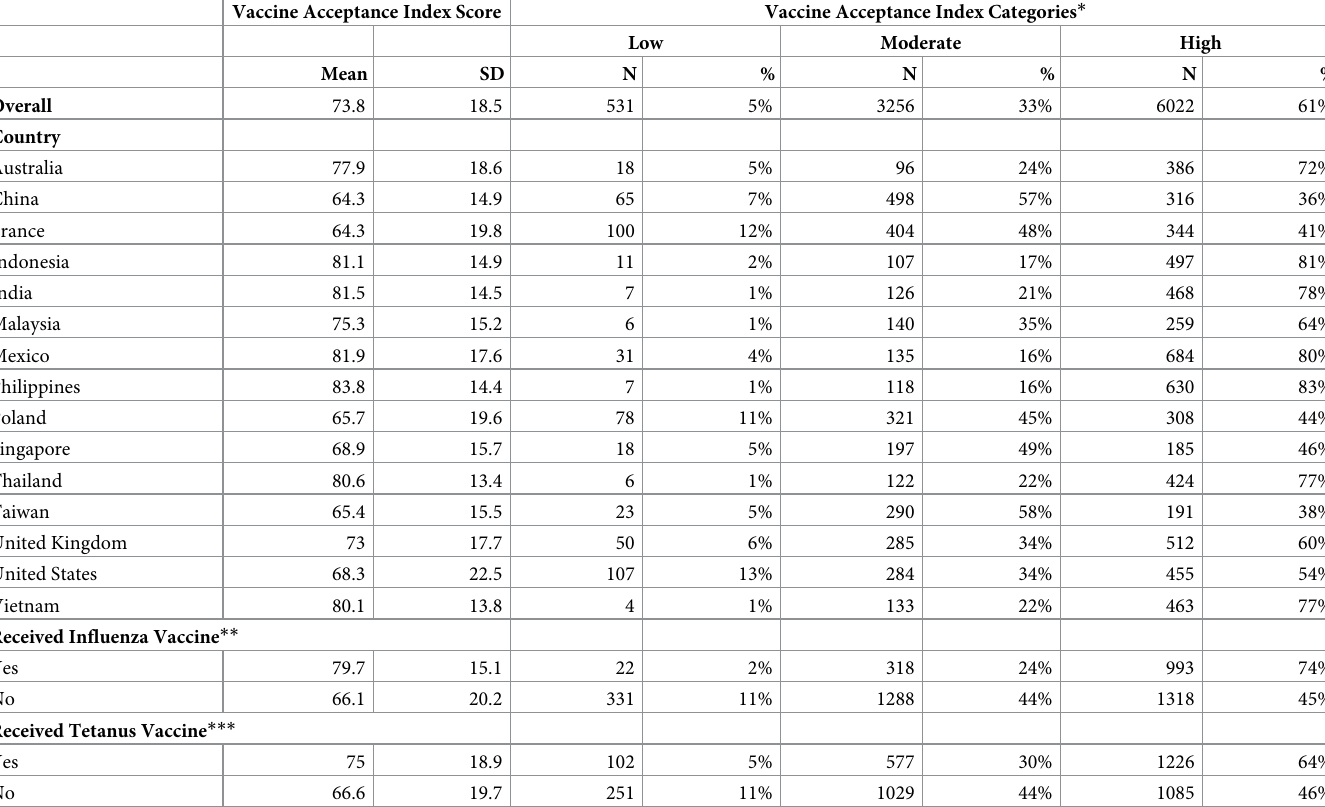
Table 3. Vaccine Acceptance Index Scores by country and sociodemographic